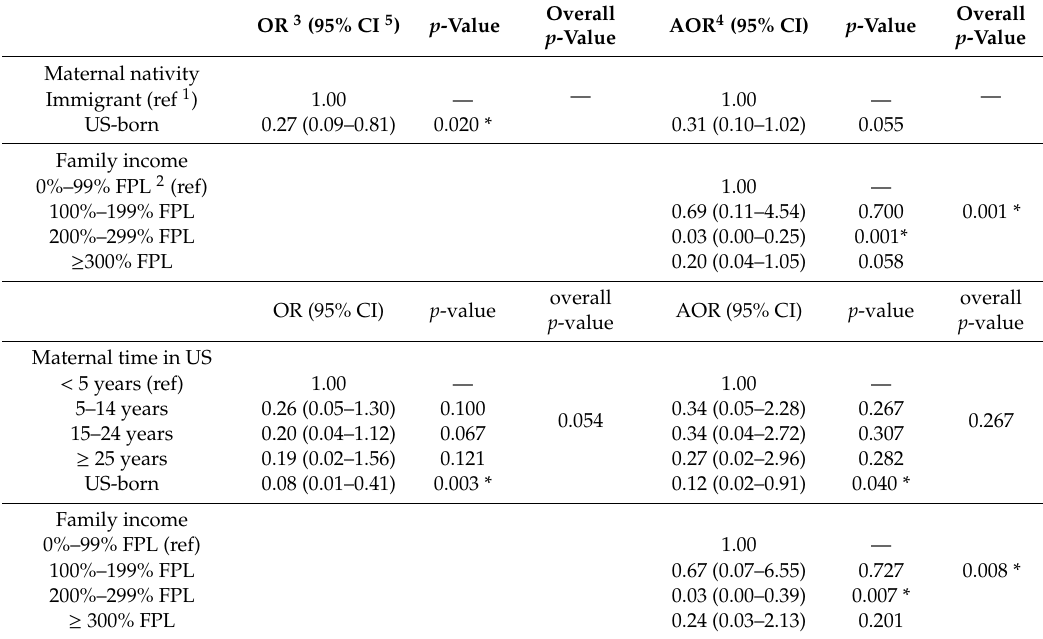
Table 3. Association between maternal nativity and maternal time in the US and obesity among Asian American children ages 2 to 11 years old (n = 609): CHIS